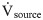
Identification of breath onset positions in polygraph nasal airflow.(a) Polygraph nasal airflow: an example of polygraph nasal airflow (V˙source), of which we need to identify breath onset positions. (b) Reduced excursion segments identification: V˙source is segmented in function of its excursion: periods with reduced excursion (pink shade) and periods without reduced excursion (blue shade). (c) Breath onset determination relying on Respiratory Inductance Plethysmography (RIP) signals: during periods with reduced V˙source excursion, as breath onset positions are difficult to be directly determined from V˙source, the reference RIP signal’s valleys temporal coordinates are used to indicate the corresponding breath onset positions in V˙source. The choice between RIP thorax and RIP abdomen to be the reference RIP signal is determined by criterion of possessing a higher relative amplitude modulation compared to the other one. (d) Breath onset determination relying on V˙source: in segments without reduced V˙source excursion, breathing onsets can be directly determined as the inflection point in V˙source between expiratory minimal and inspiratory maximal values. (e) Breath onset identification result: all breath onsets in V˙source are obtained by combining results from (c) and (d).